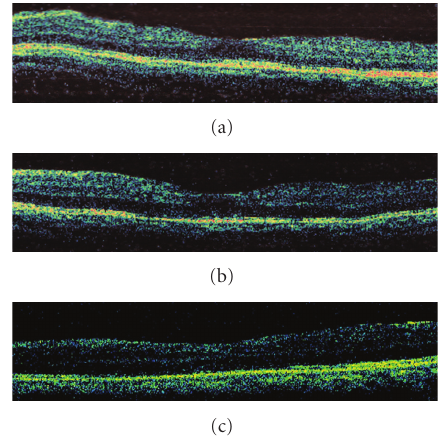
Figure 2: OCT images of Patient 5 before and after RD repair to see macular status before MH development. (a) The OCT image before the first RRD surgery. (b) The OCT image after the first RRD surgery (SB). (c) The OCT image after the second RRD surgery (PPV 10 months after the first surgery). MH was not developed yet. Four years later, she underwent the third operation for RRD repair (PPV + SB).